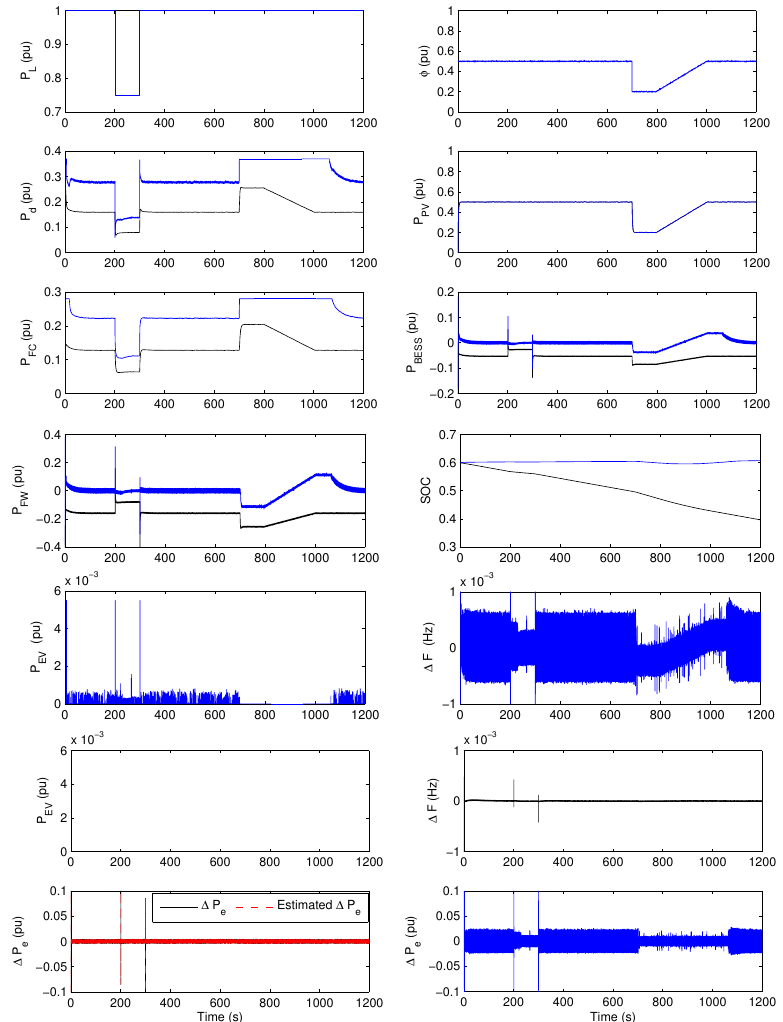
Figure 9. Case 2 simulation results: proposed (black) and conventional